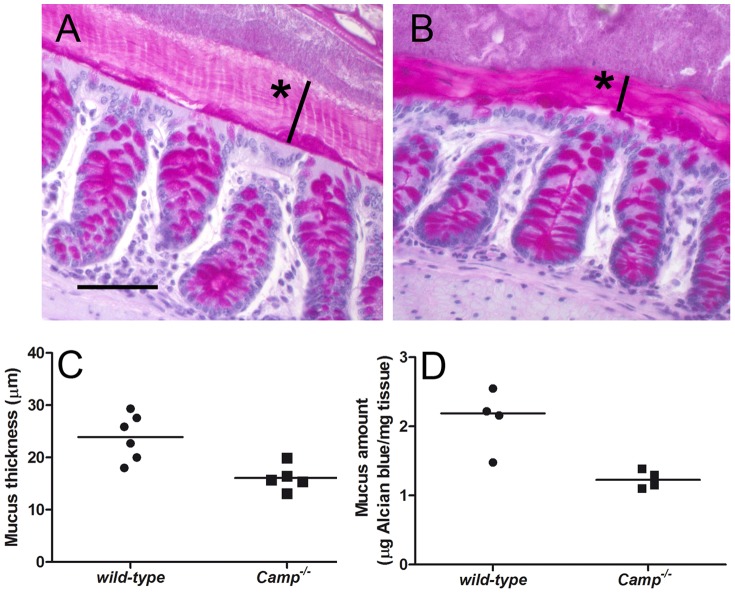
CRAMP-deficient mice have a thinner layer of mucus in the colon.(A and B) Mouse colon tissues from a representative colonic segment taken from 129/SvJ (A, wild-type) and Camp−/− (B) mice, fixed by water-free Methanol-Carnoy's fixative, stained with PAS and visualized by light microscopy. Stars indicate thickness of the inner mucus layer. Scale bar indicates 25 µm. (C) The thickness of the inner stratified layer of colonic mucus in µm. The individual values and means are displayed for each group of mice (N = 6 and 5, respectively). The inner mucus layer in Camp−/− mice was thinner by 32.7% (p<0.01) (D) The total amount of colonic mucus expressed as the amount of Alcian blue bound to mg of colonic tissue. The individual values and medians are shown (N = 4 in each group). The amount of mucus in Camp−/− mice was lower by 43.8% compared with the wild-type animals (p<0.05).